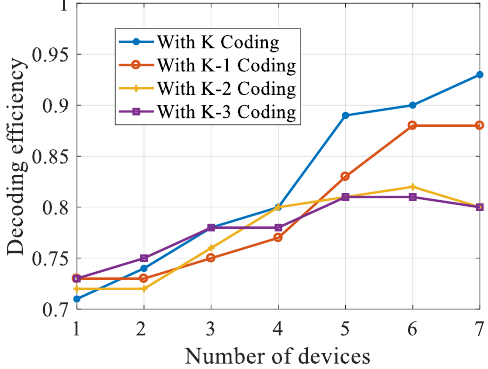
Figure 4. Influence of different re-encoding scheme on successful decoding rate (SDR).